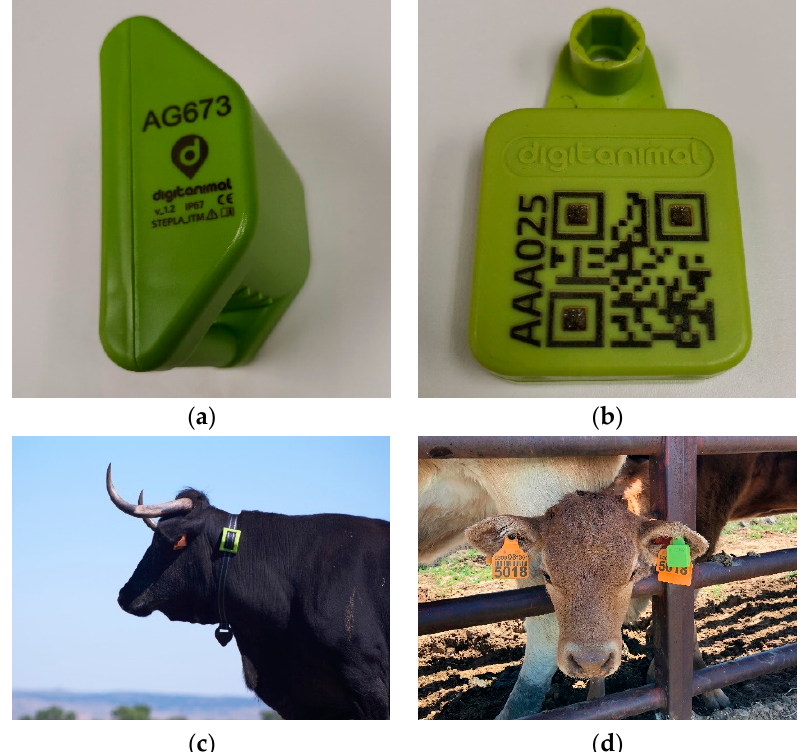
Figure 3. Hardware components of the solution: ( a ) GPS device detail; ( b ) BLE device detail; ( c ) GPS collar placed on the neck of a cow; and ( d ) BLE tag placed on the ear of a calf.